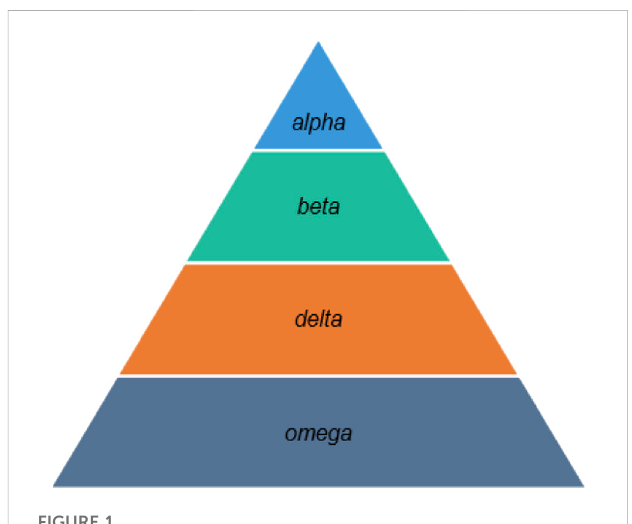
FIGURE 1 Social hierarchy of grey wolves (dominance decreases from top to